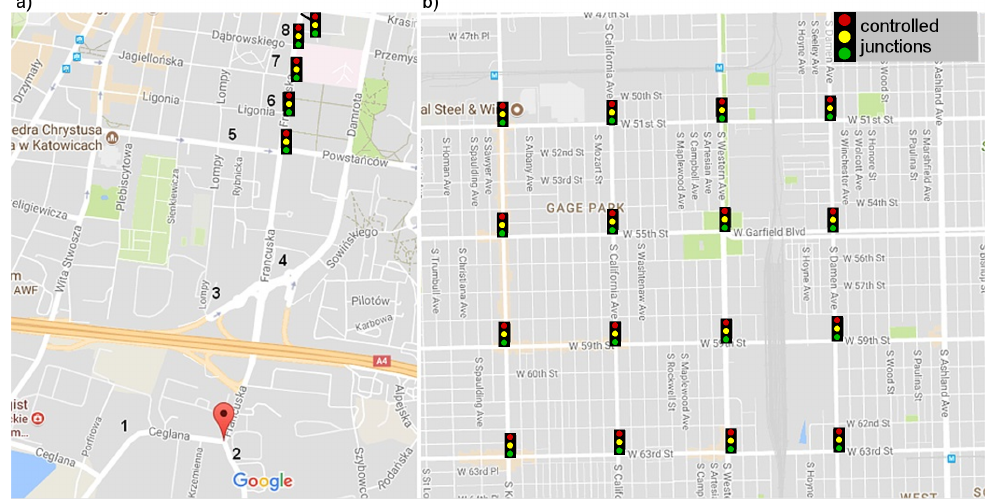
Figure 8. Test scenarios: ( a ) signalized arterial road; and ( b ) grid road network (based on google maps: http://maps.google.com).